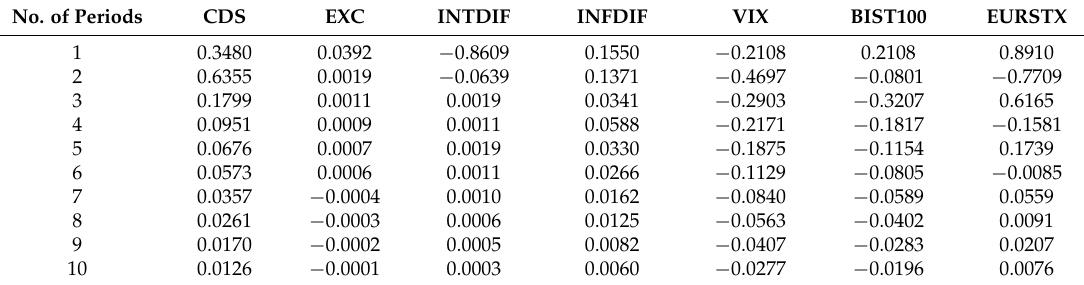
Table 8. Response of EXC to 1% positive shock in other variables in regime